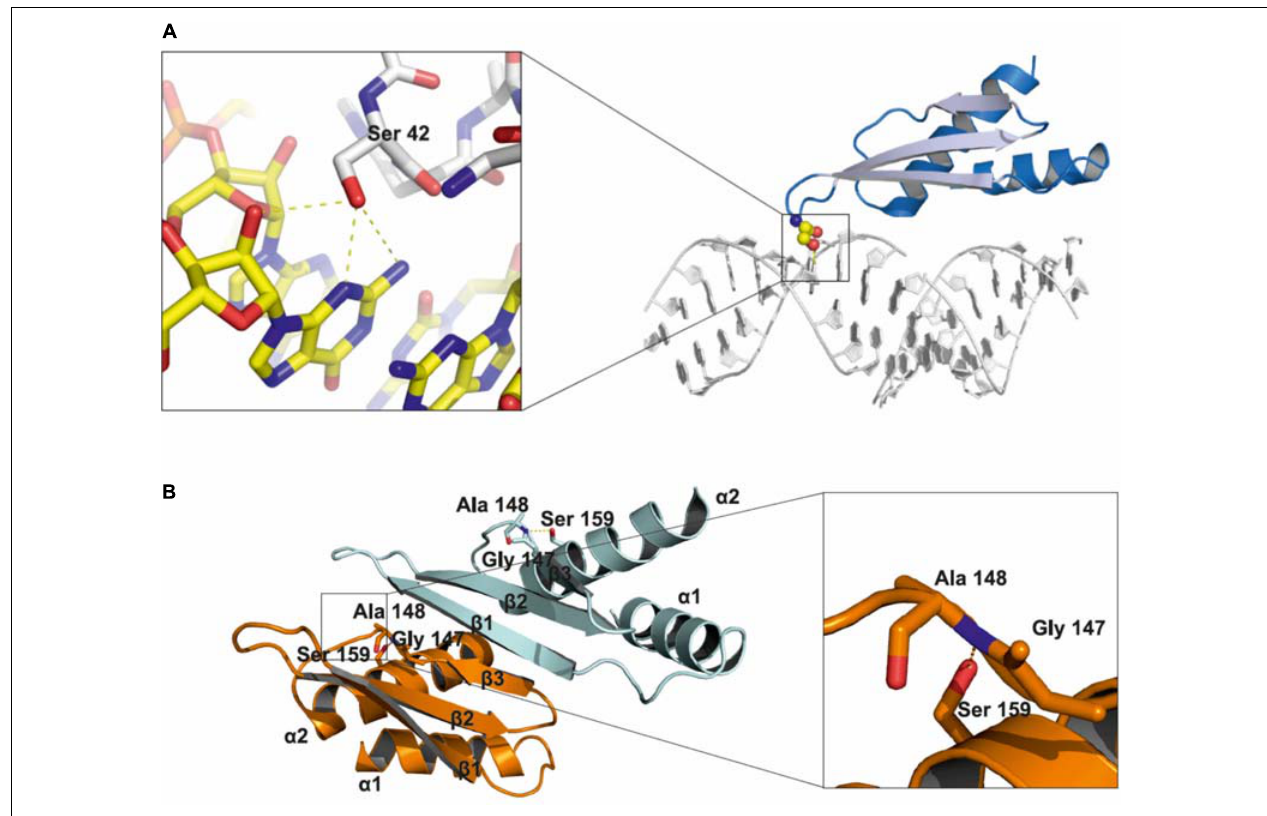
FIGURE 2 | Structural insights into the role of serine 42 and serine 159 residues in the HYL1 protein based on the crystal structure from Yang et al. (2010). (A) Interactions of non-phosphorylated serine 42 with minor groove of dsRNA. (B) Stabilization of beta strand 3 by the hydrogen bond between non-phosphorylated serine 159 and peptide bond between glycine 147 and alanine